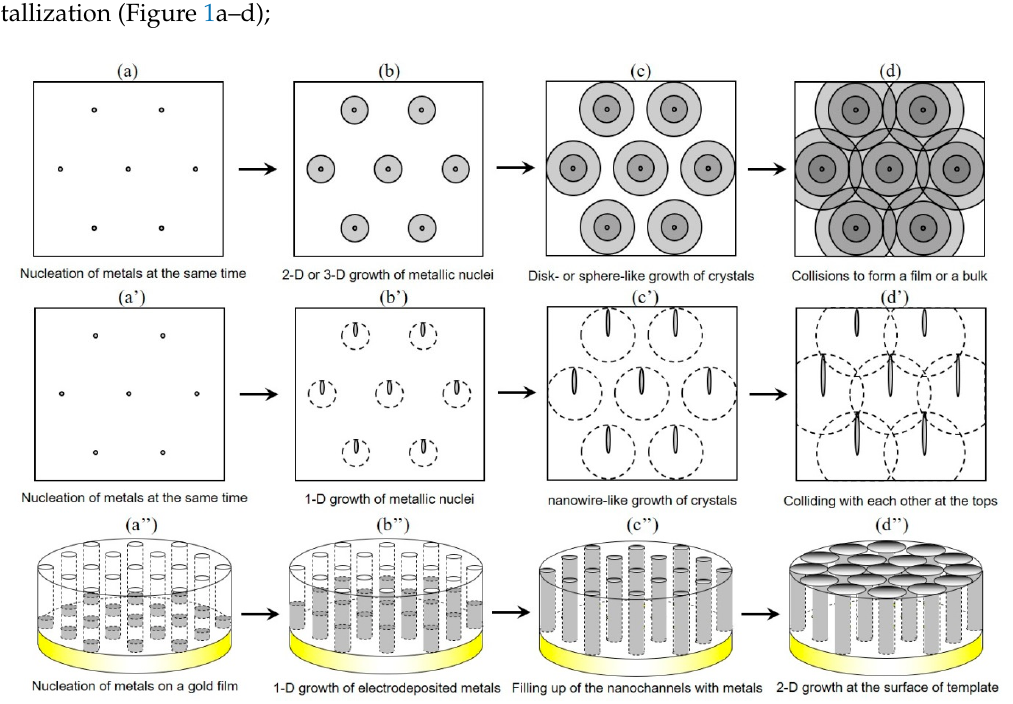
Figure 1. Schematic images of crystal nucleation and 2-D or 3-D growth process based